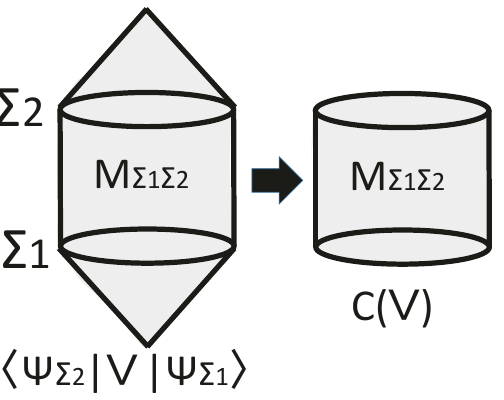
Figure 7 . The gravity dual of path-integral complexity for the Hamiltonian evolution C ( e (cid:0) iHt ). This looks identical to the upper bound of the Lloyd bound [92] with a suitable rede(cid:12)nition of the complexity by a numerical